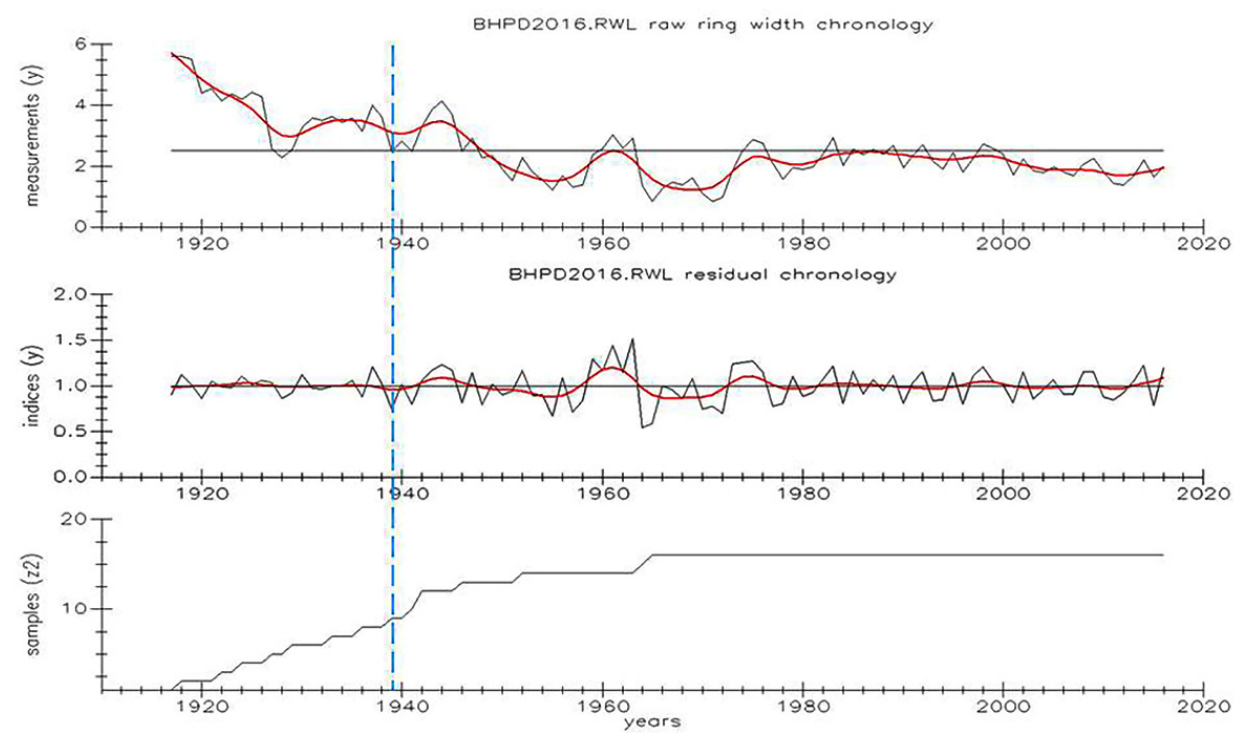
Figure 2. The chronology and sample depth of P. densiflora from Mt. Bukhan (dotted line is SSS ≥ 0.85). Table 2. Statistics of tree-ring chronologies of P. densiflora from three